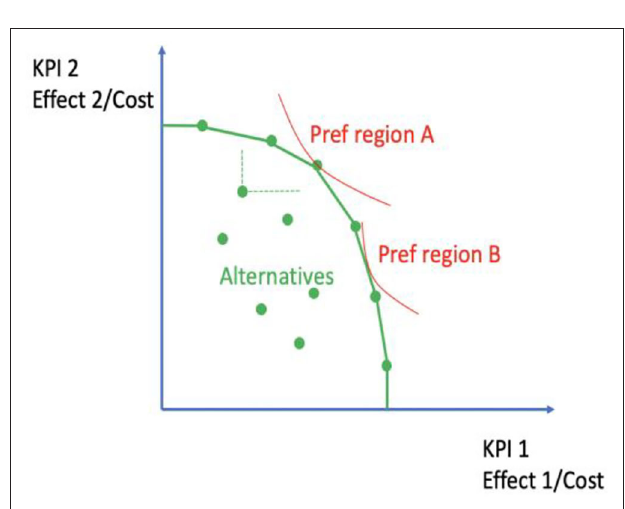
FIGURE 3 | Real life approximation of the rational decision making.